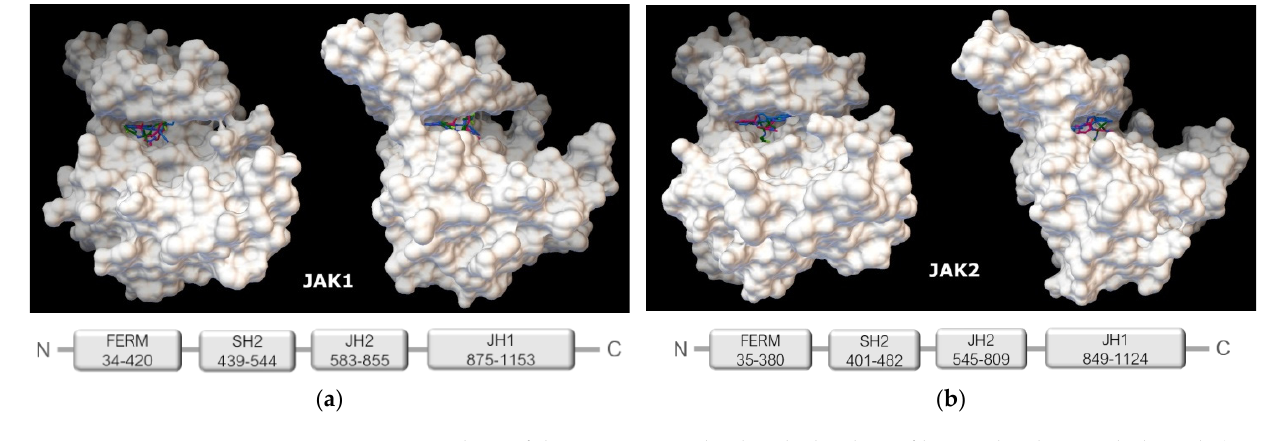
Figure 2. Topology of the “grotto” involved in the binding of low molecular weight ligands (view in two projections) in the globule of the JAK1 protein (locus 865-1154 a.a.) ( a ), JAK2 (locus 842-1130 a.a.) ( b ). Table 1. Structural and physicochemical properties of “grottoes” for JAK1 and JAK2.